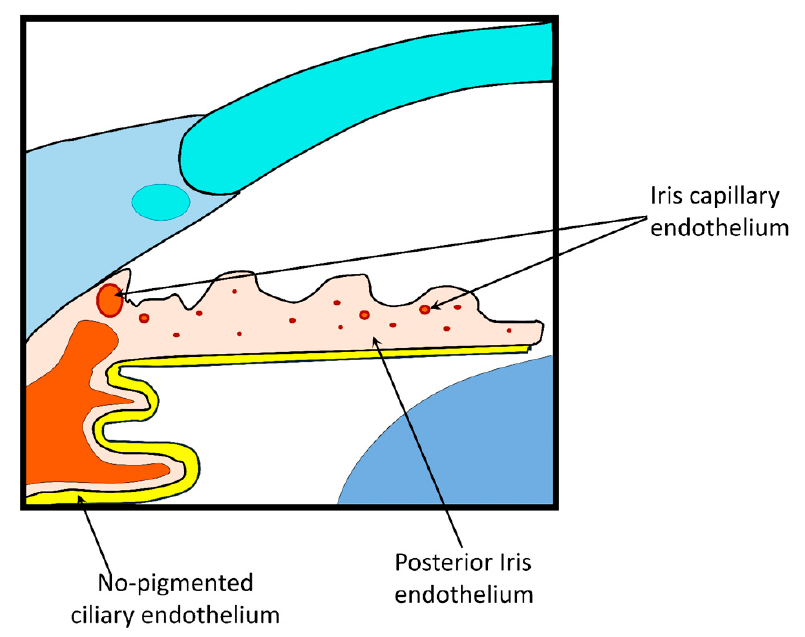
Figure 6. Blood–aqueous barrier (BAB) structure.